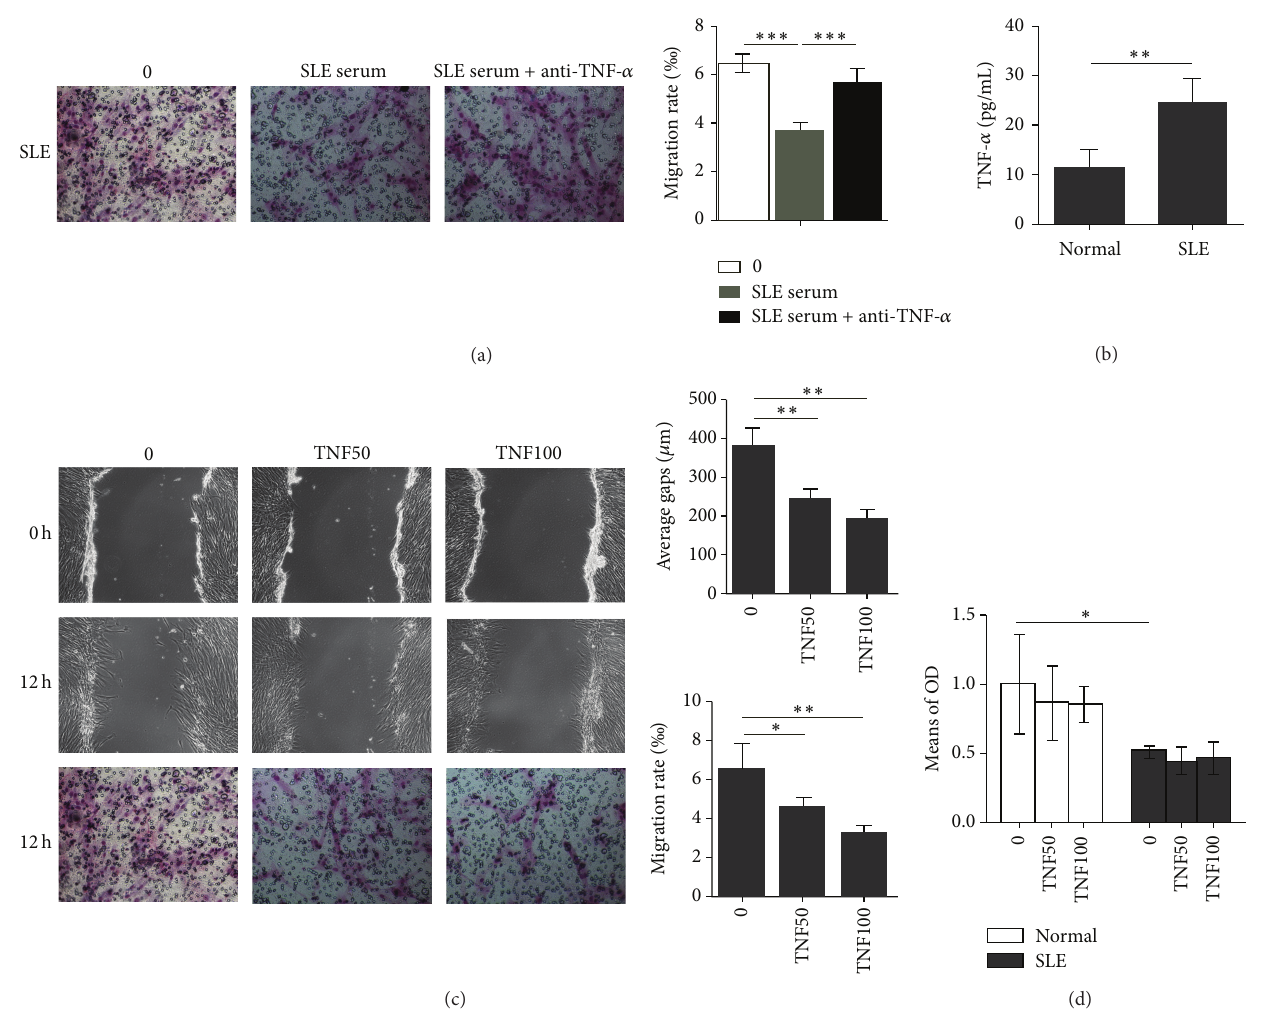
Figure 2: Association of elevated serum TNF- 𝛼 with impaired migration of SLE BMSCs. (a) TNF- 𝛼 blockers restored the decreased SLE BMSCs migration capacity induced by SLE serum ( 𝑛 = 6 ). (b) Serum level of TNF- 𝛼 was significantly elevated in SLE patients compared to that of healthy controls. (c) TNF- 𝛼 significantly decreased migration capacity of SLE BMSCs both in the wound healing ( 𝑃 = 0.003 ) and transwell migration assays ( 𝑛 = 6 ). (d) TNF- 𝛼 at either 50 𝜇 g/L or 100 𝜇 g/L had no impact on the proliferation rate of BMSCs from both healthy controls and SLE patients. TNF50: TNF- 𝛼 : 50 𝜇 g/L; TNF100: TNF- 𝛼 : 100 𝜇 g/L. ∗ 𝑃 < 0.05 ; ∗∗ 𝑃 < 0.01